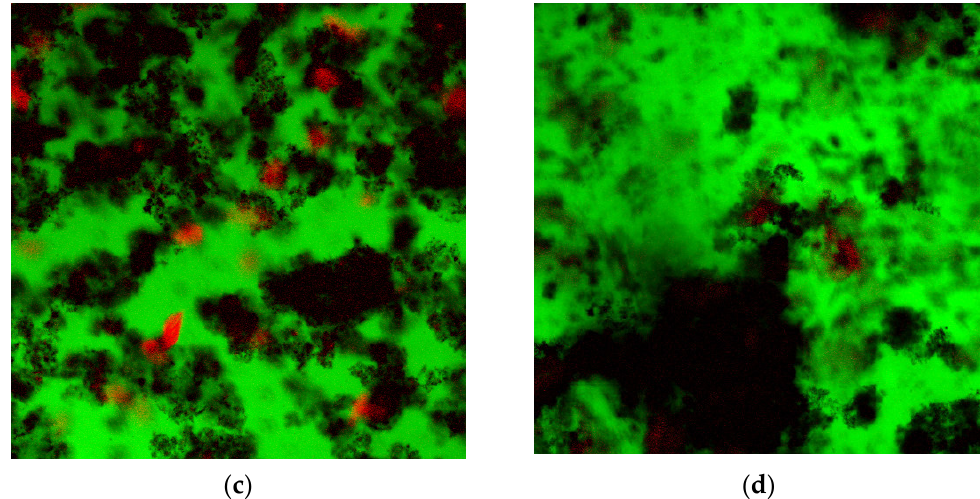
Figure 5. Confocal Laser Scanning Microscopy (CLSM) images showing VSC-producing bacteria (stained red) within the biofilm (black) formed on the PMMA discs (green) following pre-disinfection using: ( a ) Saline (negative) control, ( b ) essential oil formulation, ( c ) herbal extract formulation, and ( d ) chlorhexidine formulation.